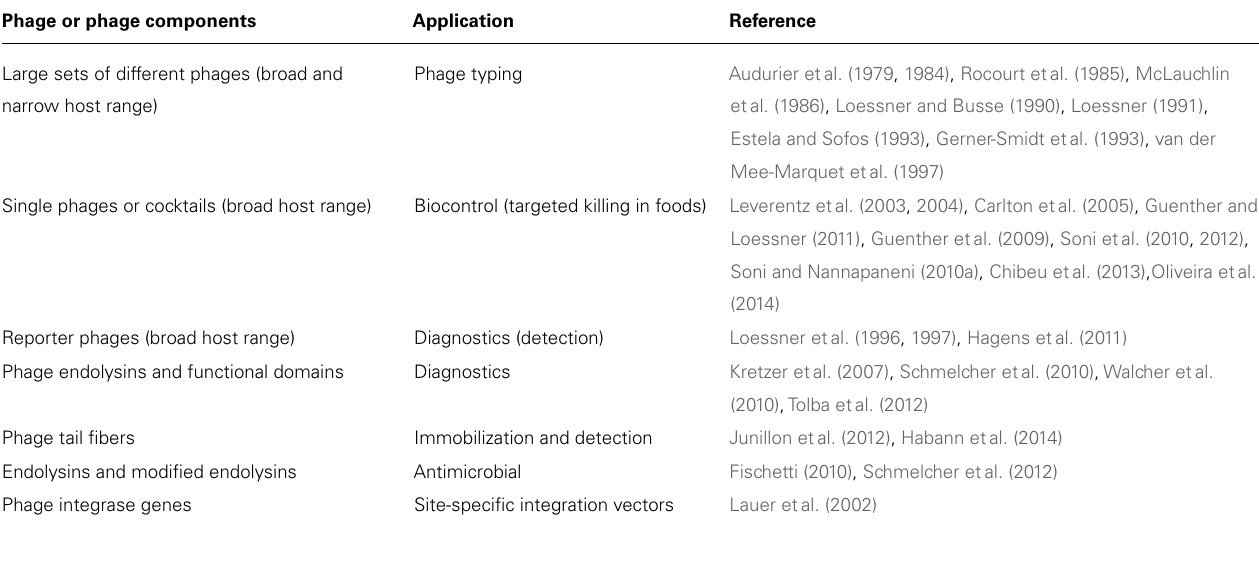
Table 1 | Listeria phage-derived